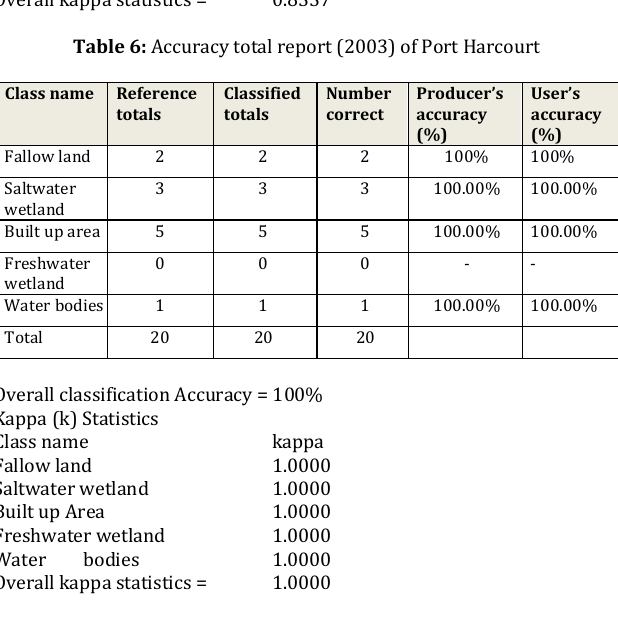
Table 7: Accuracy total report (2013) of Port